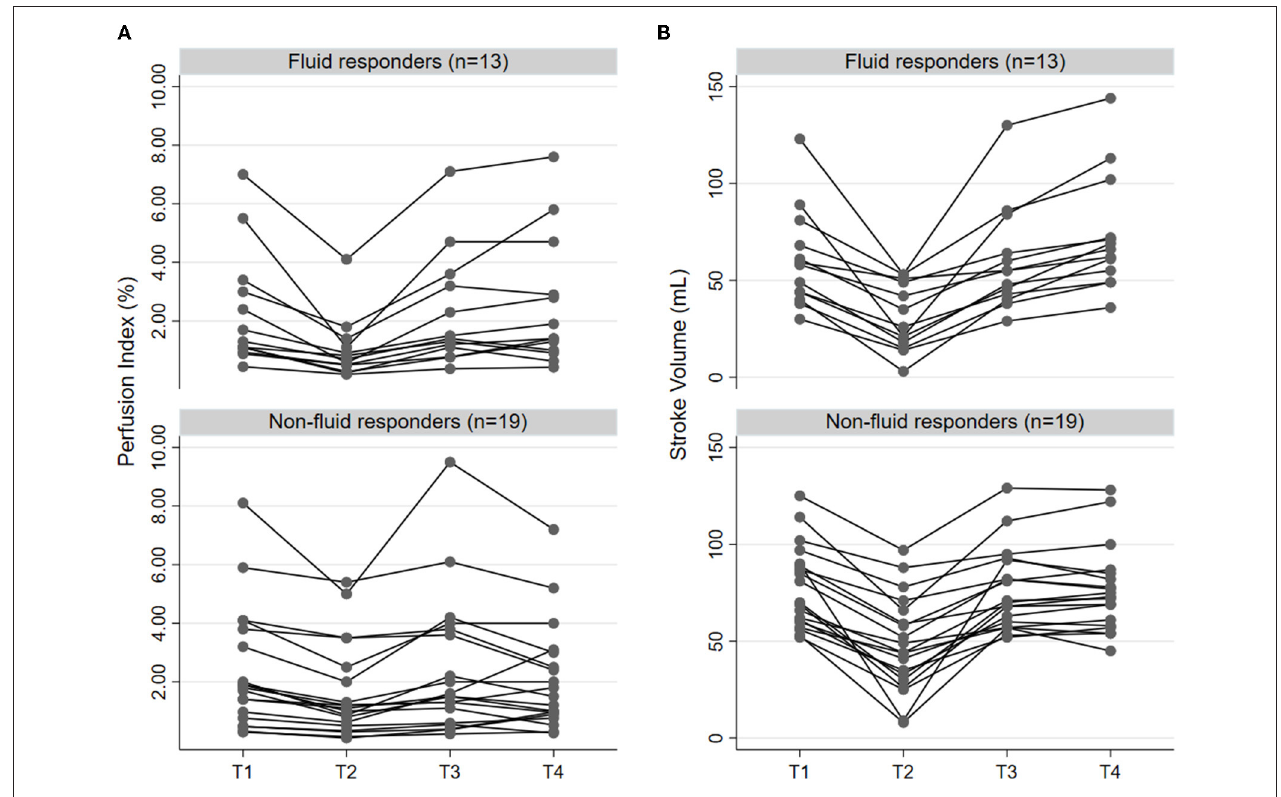
FIGURE 1 | Individual change of prefusion index (A) and stroke volume (B) according to the status of fluid responsiveness ( n = 13) and non-responsiveness ( n = 19) in four time points, including before LRM (T1), after LRM (T2), before VE (T3), and immediately after VE (T4). LRM, lung recruitment maneuver; VE, volume expansion. < 10%), hemodynamic variables and PI were obtained as the second baseline values (T3); then, VE was infused and these hemodynamic variables and PI were recorded immediately after VE (T4) [Supplemental Digital Content (SDC), Figure 1